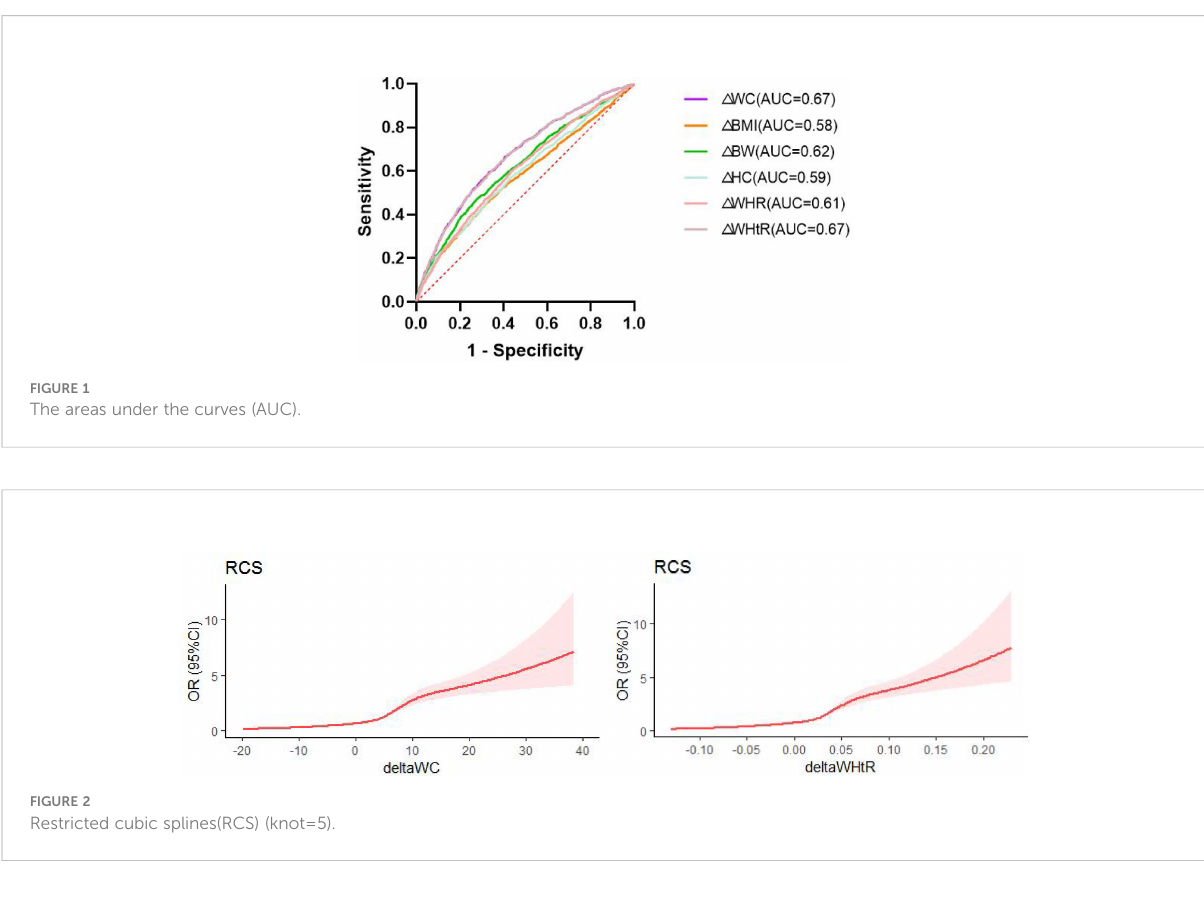
TABLE 4 Subgroup analyses by age, sex and central obesity (abdominal) status at